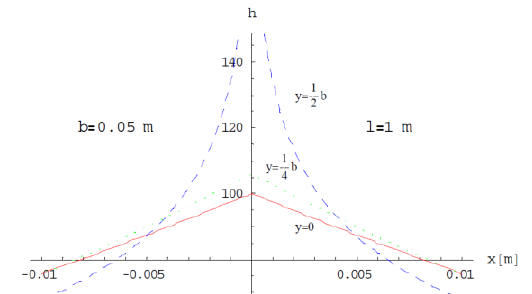
Fig. 2. Distribution of the magnetic field modulus on the plane xOy of the ribbon busduct of finite length.